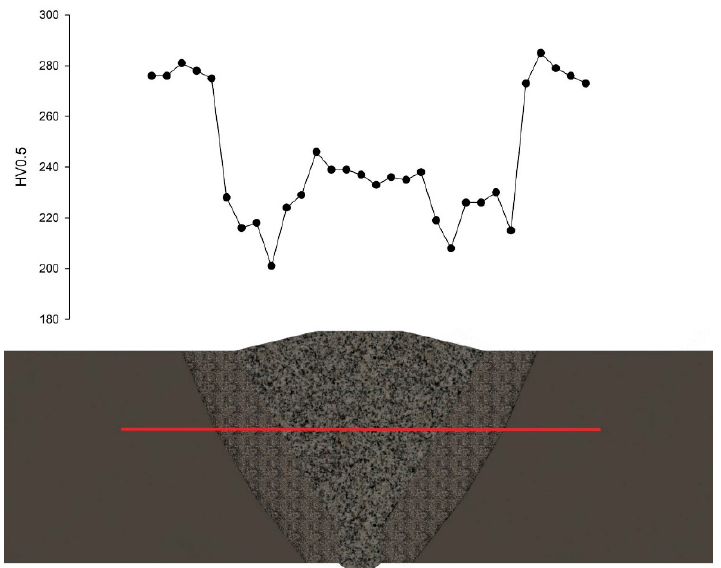
Figure 6. Results of microhardness measurement through the base metal, heat affected zone and weld metal (BM-HAZ-WM) zones of the welded joint.